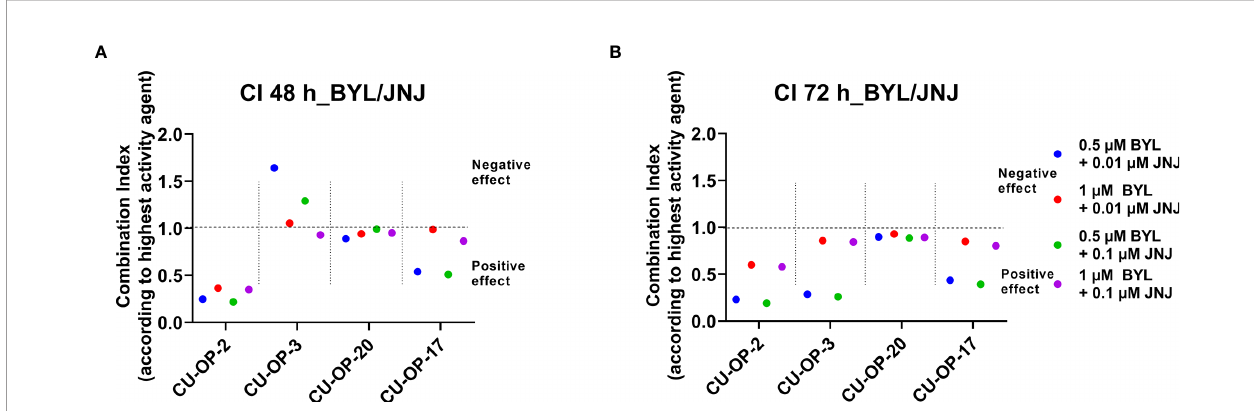
FIGURE 3 | Combinational effects of PI3K inhibitors BYL719 and FGFR inhibitor JNJ-42756493 in HPV + CU-OP-2, -3, -20 and HPV - CU-OP-17 cell lines after 48 and 72 h. Combination indexes (CIs) were shown with the highest single agent approach after 48 h (A) and 72 h (B) , where CI>1 shows a negative combination effect and CI<1 shows a positive combination effect. CIs were calculated from the mean of three experiments analyzed by WST-1, at 48 and 72 h after treatment. CI denotes combination index; BYL denotes BYL719 and JNJ denotes